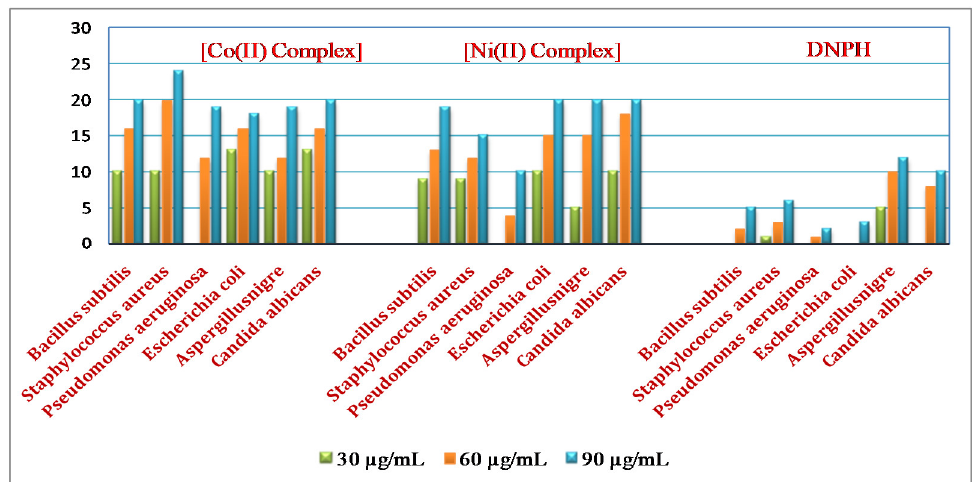
Figure 5. Results of the antimicrobial potential screening for DNPH and its metal complexes.